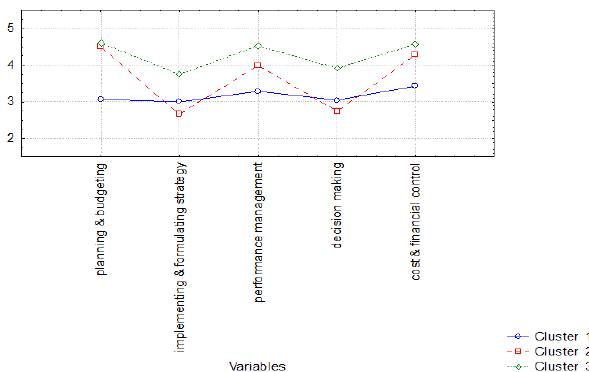
Fig. 4. The results of object (respondent) grouping with the k-means method as regards the use of management accounting information for indicated management tasks by managers in